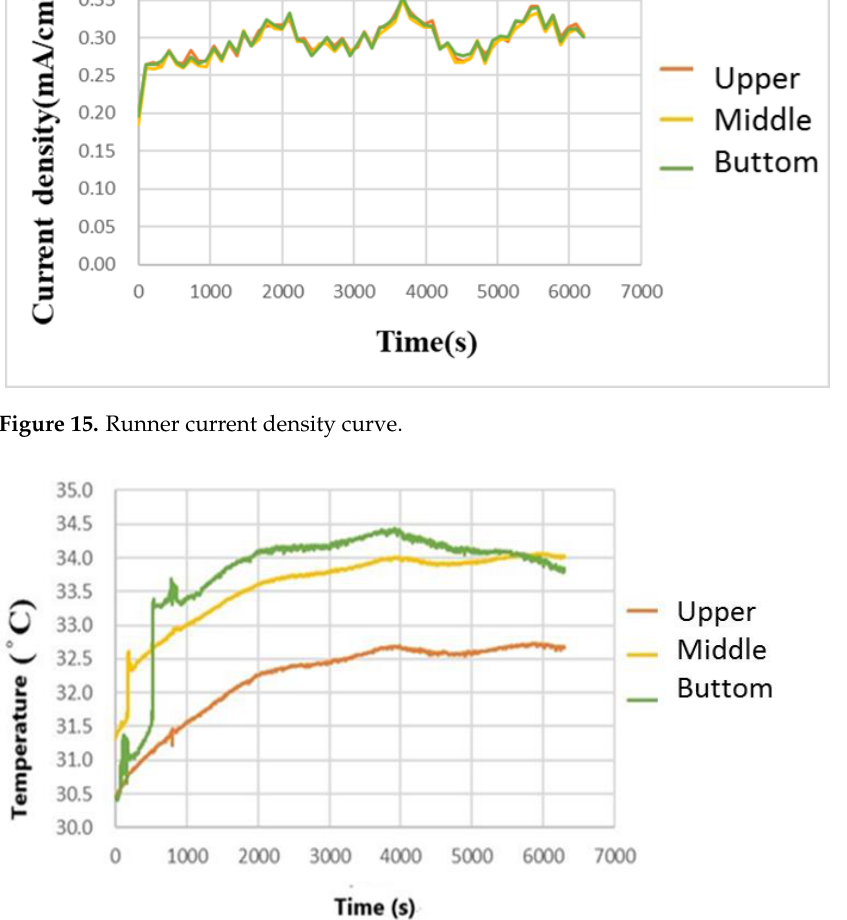
Figure 16. Runner charging temperature curve.